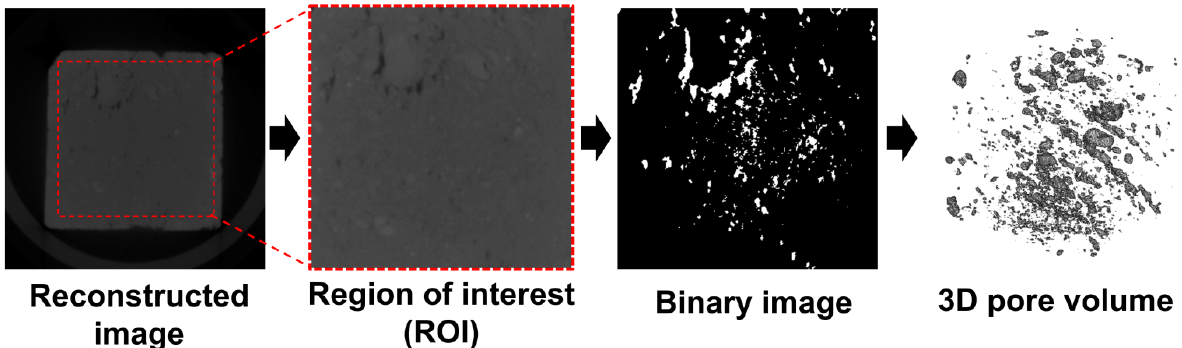
Figure 3. Micro-CT imaging procedure for classifying pores in a target specimen and for visualizing them in 3D.